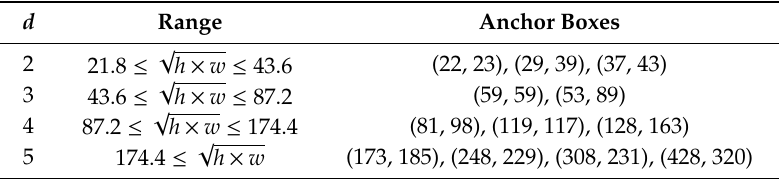
Table 3. The allocation of clusters on PASCAL VOC dataset at each